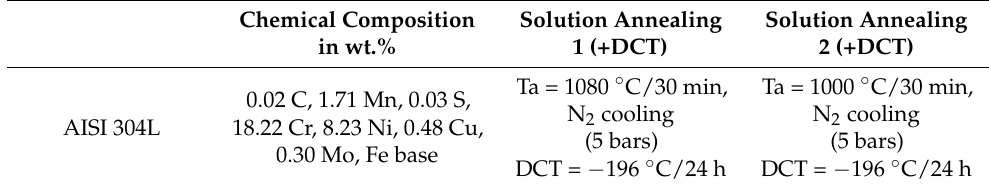
Table 1. Chemical composition of selected stainless steels is given in mass content (wt.%). Heat treatment parameters are given for hardening and deep cryogenic treatment (DCT). Chemical Composition in